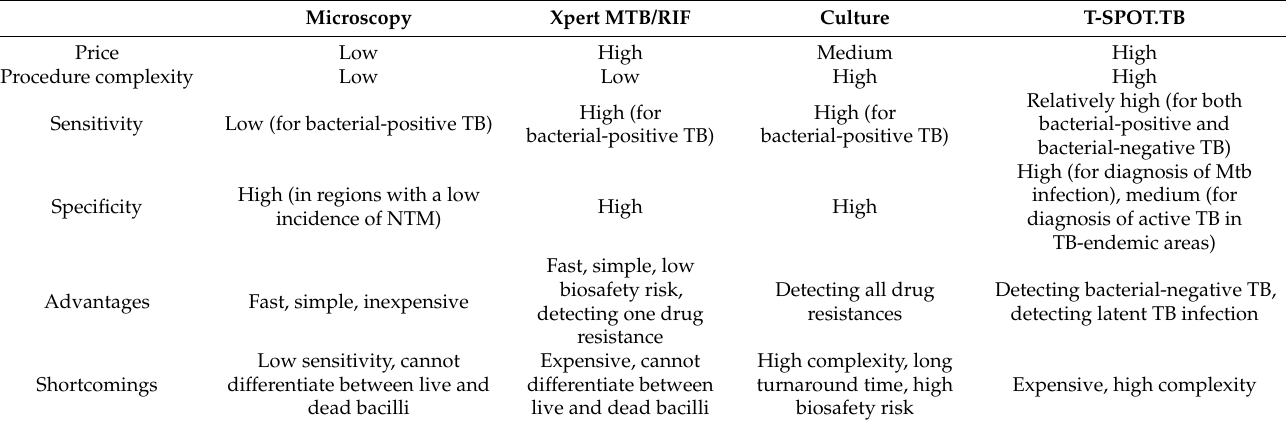
Table 1. Comparison of the typical methods for diagnosis of TB